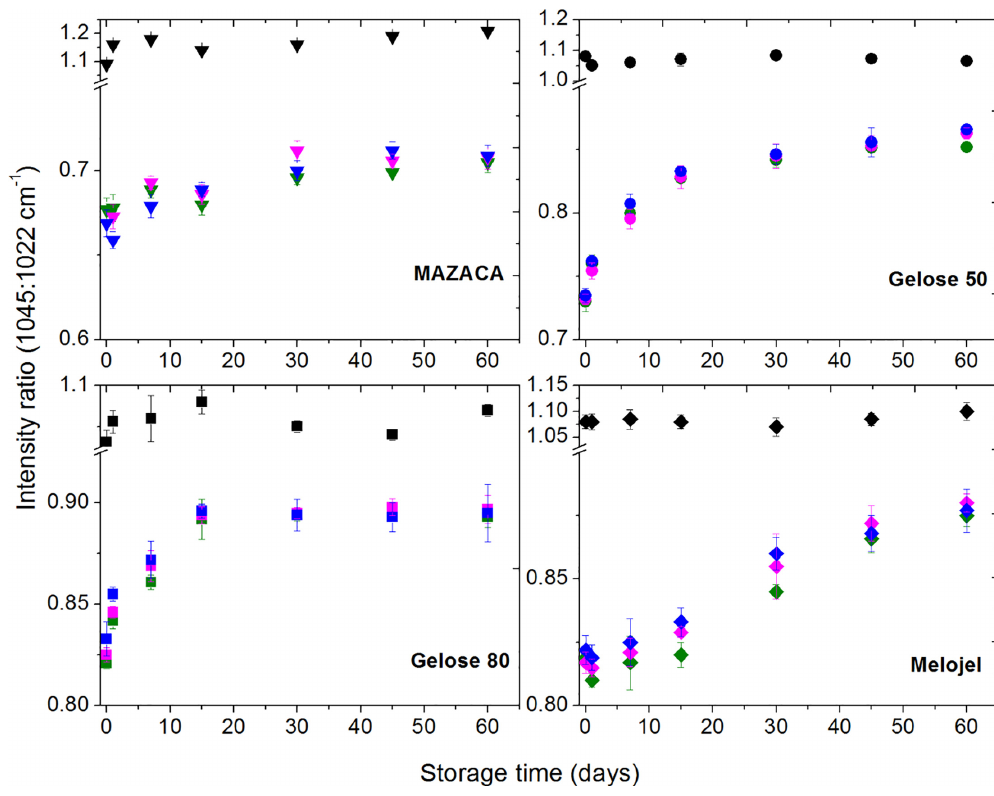
Fig 3. Retrogradation monitored using the FTIR absorbance ratio 1045:1022 cm -1 for Gelose 50, Gelose 80, MAZACA, and Melojel. Black: Non-treated control sample, Olive: Pressure releasing rate: 50 MPa/min, Magenta: Pressure releasing rate: 100 MPa/min, Blue: Pressure releasing rate: 900 MPa/min.